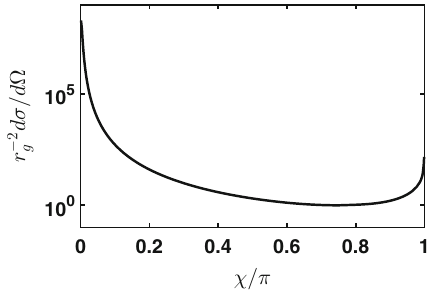
Fig. 8 The differential cross section of the gravitational scattering of scalar particles off a nonrotating BH, normalized by r 2 g , versus χ/π . The particle energy is E = 10 m Fig. 9 The illustration of the particle scattering off a rotating BH. a Direct scattering; b retrograde scattering